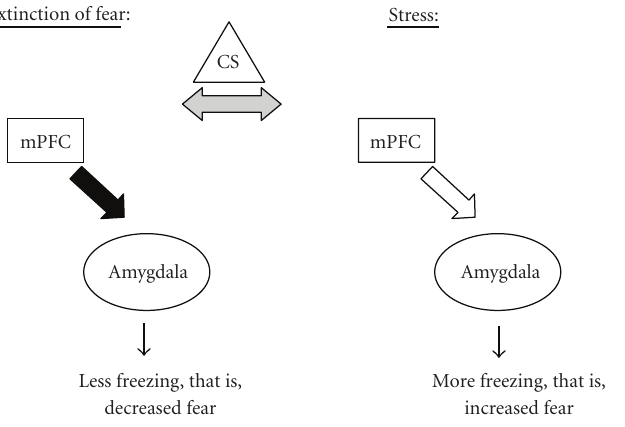
Figure 4: A possible mode of action for the medial prefrontal cortex-amygdala circuit in fear extinction under normal and stressful conditions. Under normal conditions of fear suppression, the medial prefrontal cortex (mPFC) is activated and inhibits amygdala output (filled arrow). This dominance of the mPFC results in less freezing in response to a conditioned stimulus (CS; i.e., extinction). However, under stressful conditions, the inhibitory action of the mPFC on the amygdala is reduced (empty arrow), the amygdala dominates (indicated by the bold circle around the amygdala) and the result is more freezing in response to a CS (i.e., impaired